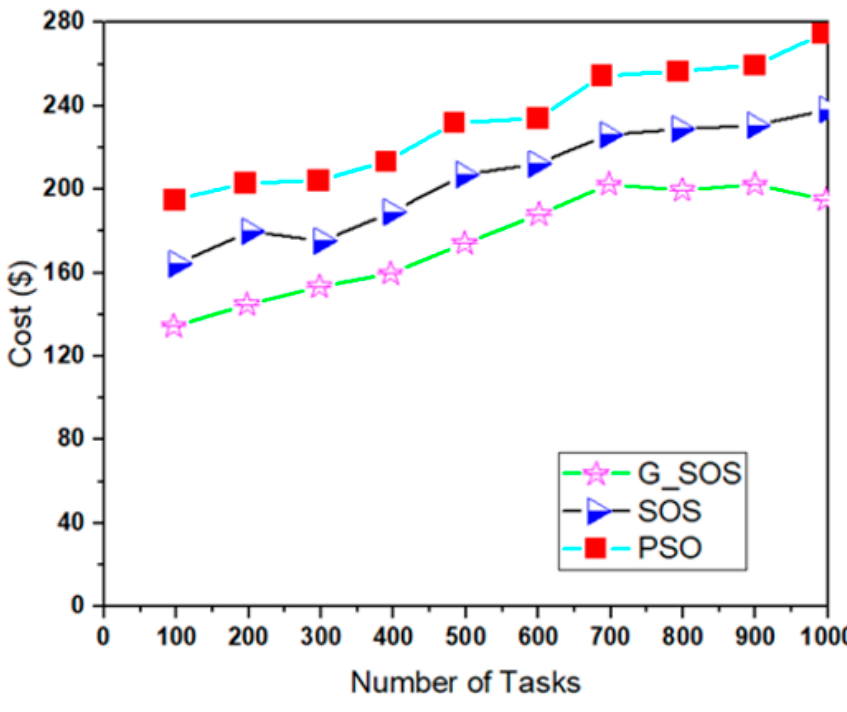
Figure 3. Average cost corresponding to the number of tasks.